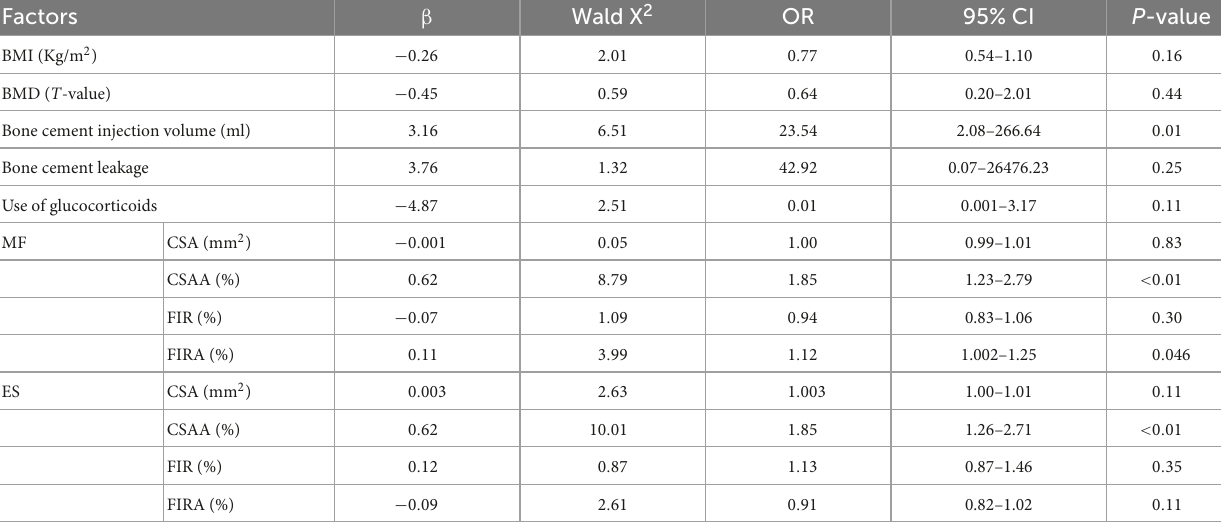
TABLE 3 Multivariate logistic regression analysis of recurrent fracture after